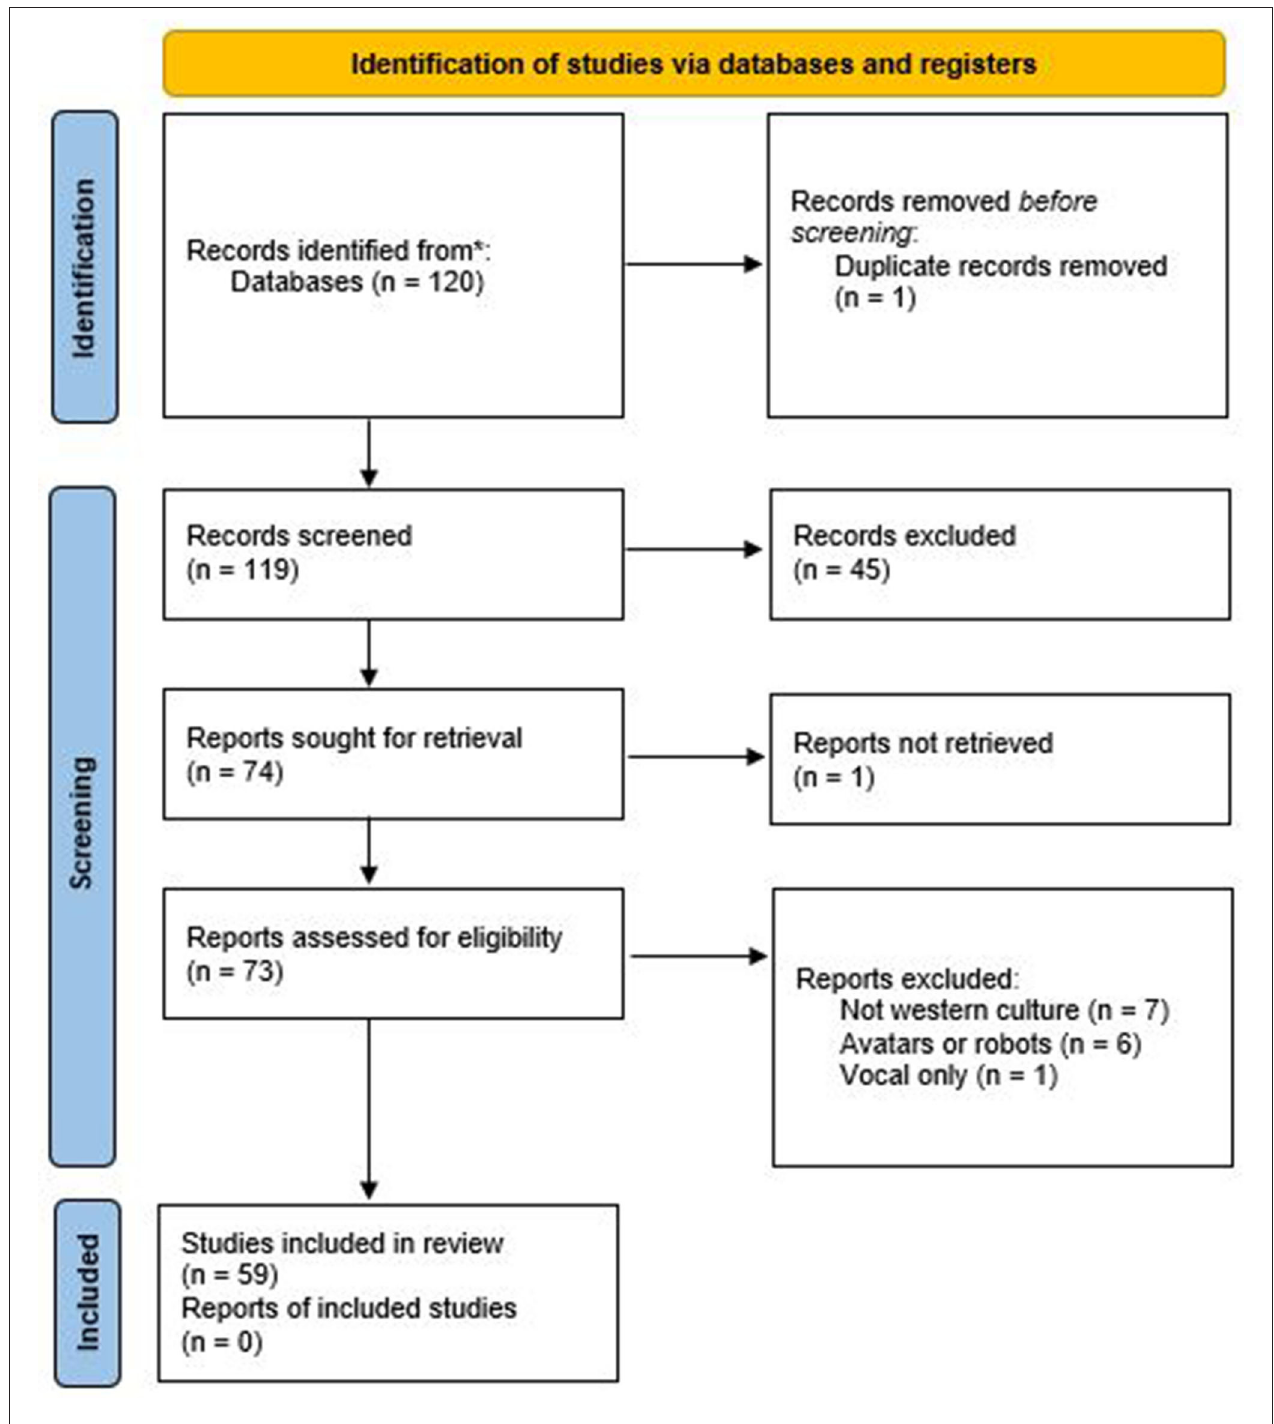
FIGURE 1 | PRISMA 2020 flow diagram for new systematic